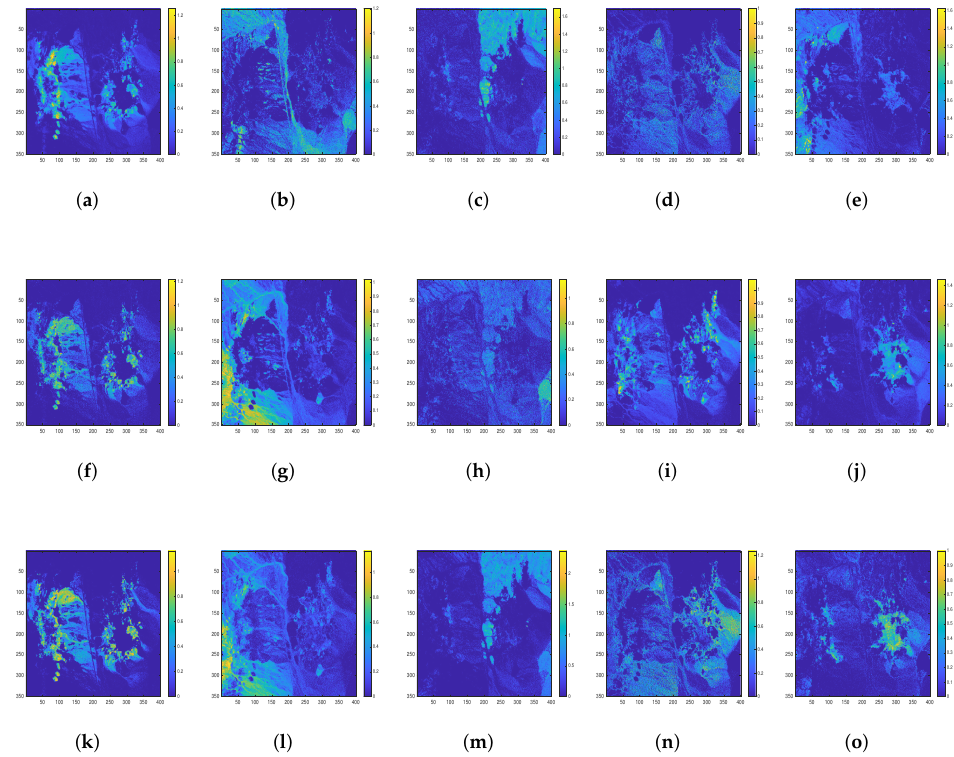
Figure 8. The abundance maps of five endmembers obtained from ( a – e ) ASAEE-GA. ( f – j ) ASAEE- PSO. ( k – o )